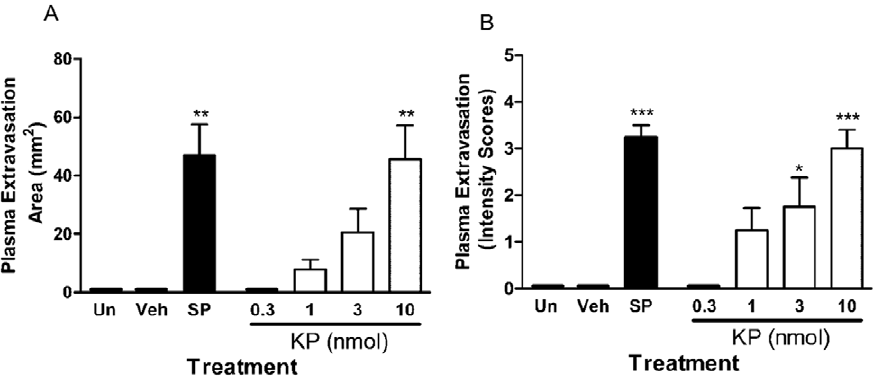
Figure 1. Kisspeptin-10 causes a dose-dependent increase in oedema formation in the cutaneous vasculature. Female CD1 mice were anaesthetised, injected with Evans Blue dye i.v. and treated intradermally in the dorsal skin with 0.3–10nmol kisspeptin-10 (KP), 300pmol substance P (SP) or saline control (Veh) for 30 minutes. An uninjected site was also included (Un). Plasma exudation was allowed to continue for 30 minutes post- injection at which point mice were killed, dorsal skin removed and the area of oedema measured (A). The lesion was also scored for colour intensity (B). Results are shown as mean area (mm 2 ) 6 SEM, N =4. *=p # 0.05, **=P # 0.01, ***=p # 0.001 assessed by one-way ANOVA compared to vehicle